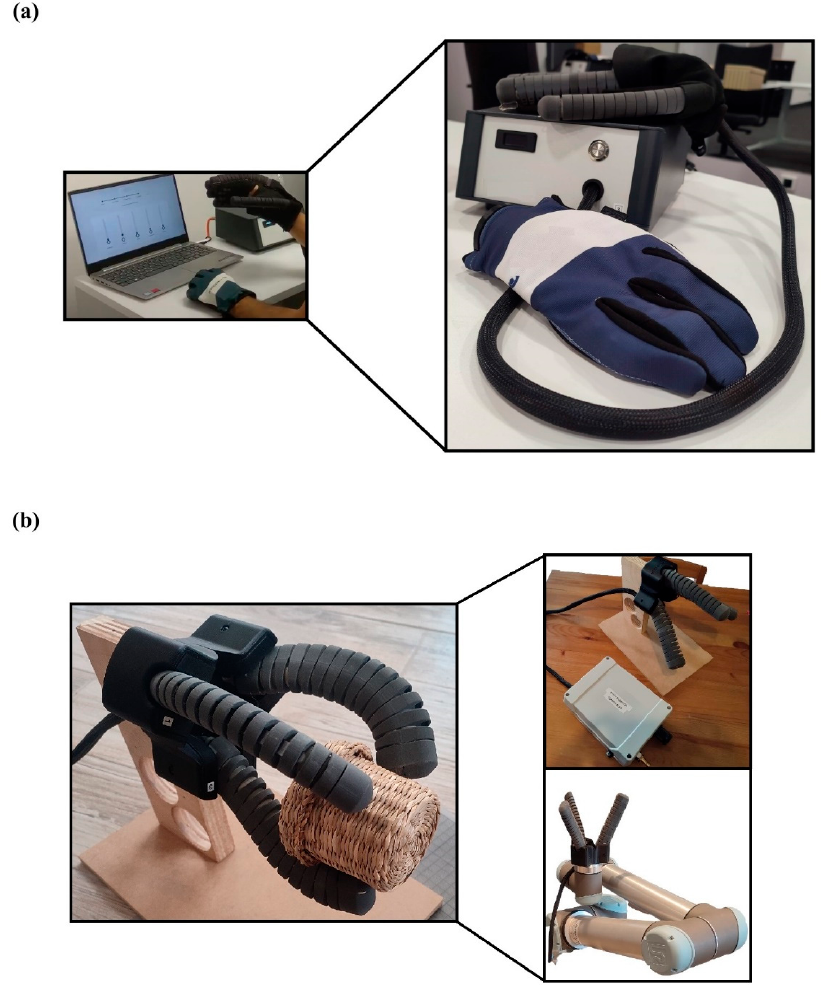
Figure 9. Indicative applications for the developed actuator: ( a ) Exoskeleton for medical applications to assist patients with mobility difficulties; ( b ) Soft gripper for the handling of delicate objects.